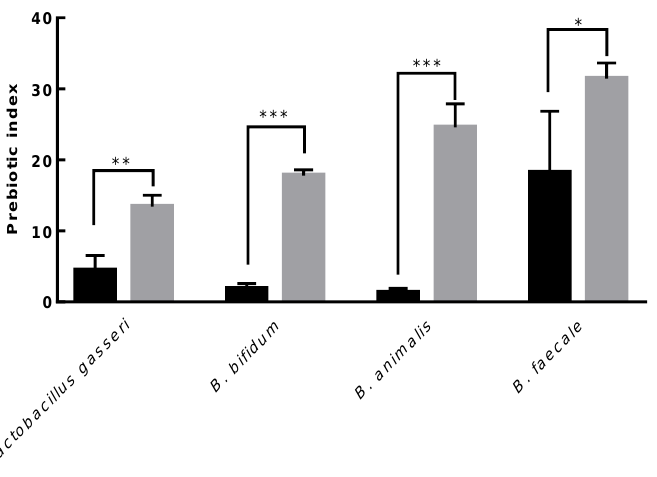
Figure 11. Prebiotic effect of EPS from L. paracasei EPS DA-BACS on probiotic strains. Black bar is inulin and gray bar is EPS from L. paracasei EPS DA-BACS. Asterisks show significant differences among groups at *, p < 0.05; **, p < 0.01; ***, p < 0.001 ( n ≥ 3) using one-way ANOVA and Dunnett’s test .